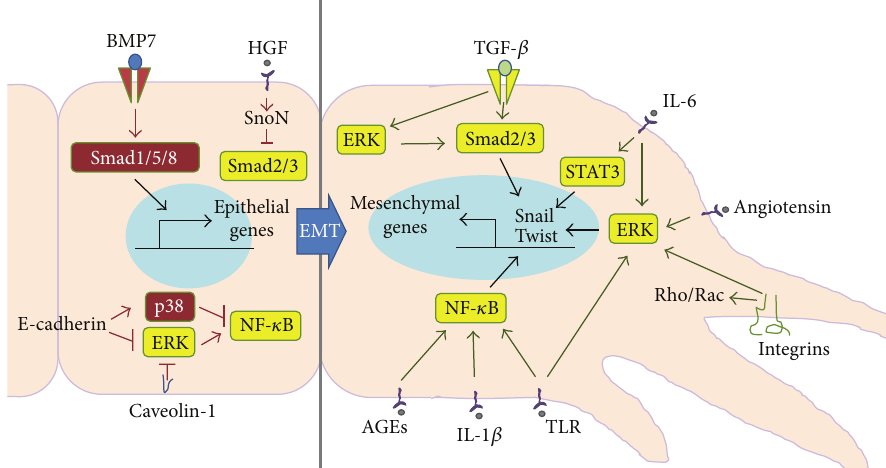
Figure 1: The epithelial/mesenchymal status of MCs is due to the balance of signals delivered by multiple receptors. Stimuli promoting EMT are delivered by TGF- 𝛽 in cooperation with inflammatory cytokines and other mediators such as IL-1 𝛽 , IL-6, TLR ligands, AGEs, and angiotensin. Smad2/3 pathway plays a main role in combination with ERK1/2 and NF- 𝜅 B pathway and all converge on the expression of Snail, the master gene of EMT. Integrin activation promotes the induction of conformational changes and the invasivity of MCs. On the other hand, signals delivered by BMP7 and HGF favor the epithelial phenotype through the activation of Smad1/5/8 and the inhibition of the Smad2/3 signaling. Also, signals delivered by cell-to-cell confluency (E-cadherin omotypic junctions) may lead to predominance of p38 MAPK over ERK1/2 and to the inhibition of NF- 𝜅 B activity. Caveolin-1 organizes signaling platforms favoring the stability of membrane receptors and inhibiting the Ras/MEK/ERK1/2